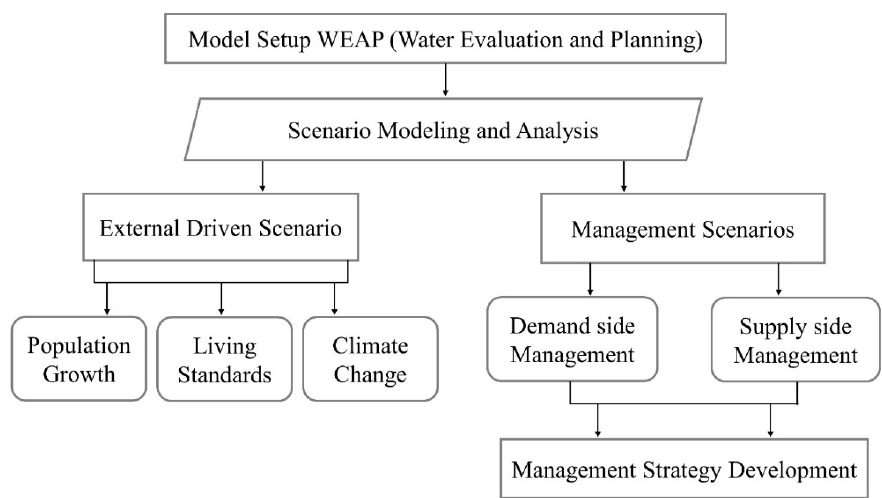
Figure 8. An image showing the workflow of the externally driving scenarios, the impact of climate change, and the management scenarios used in the